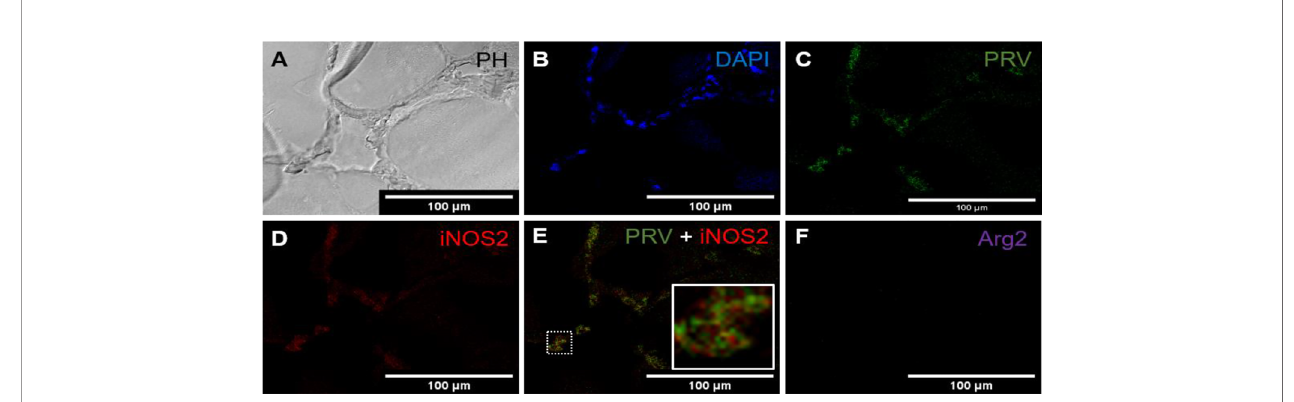
FIGURE 3 | Fluorescent in situ hybridization of PRV-1, iNOS2 and Arg2 in red focal changes (intermediate phase). (A) Phase contrast image showing in fi ltrating cells between myocytes. (B) Nuclei DNA staining of the cells with DAPI (blue). (C) Presence of PRV-1 (green) in in fi ltrating cells in between myocytes. (D) Presence of iNOS2 (red) in in fi ltrating cells between myocytes. (E) Merged image showing co-localization (inset) of PRV-1 and iNOS2 (yellow). (F) Arg2 transcripts (purple) were not detected. Scale bar